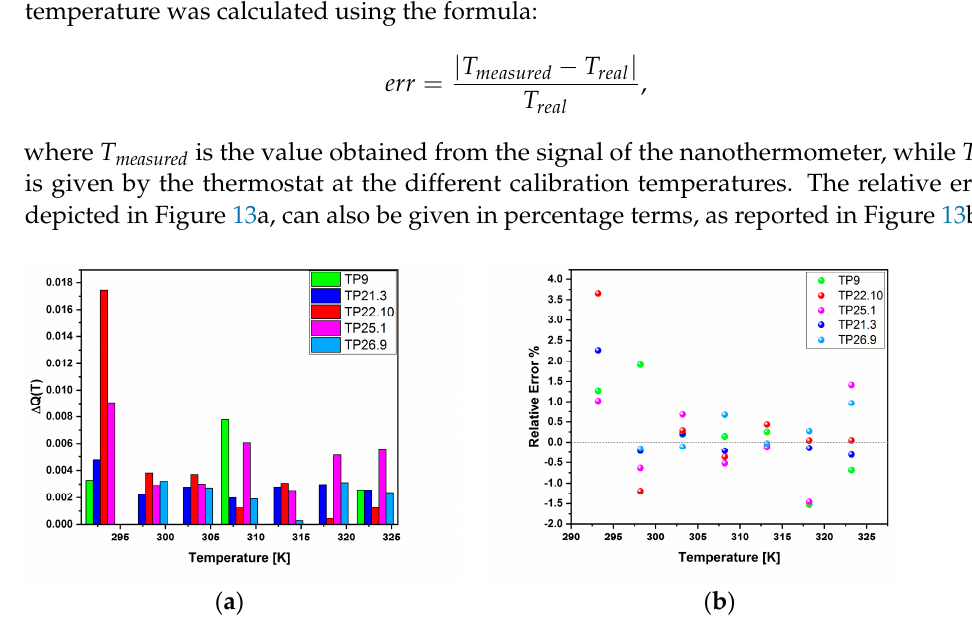
Figure 13. Comparison diagram between the relative ( a ) and percentage ( b ) errors committed by the different thermometers at the calibration temperatures.